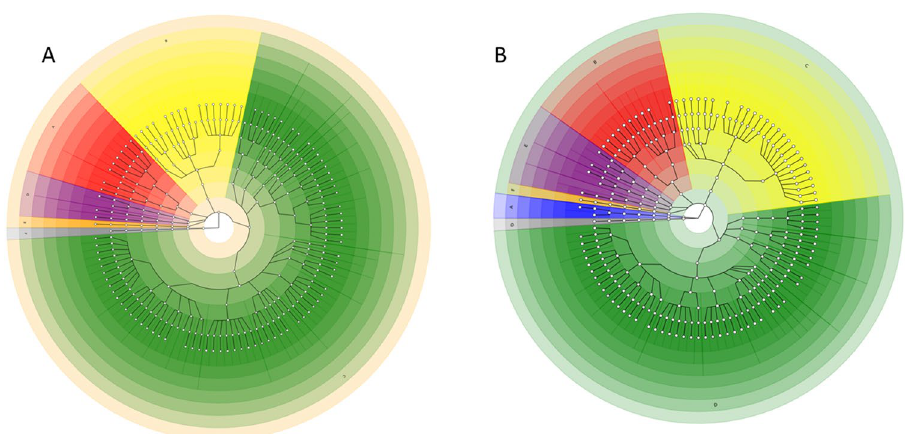
Figure 4. Graphlan generated phylogenetic tree of 16S rRNA based phylogenetic composition of the CF ( A ) and control ( B ) groups. CF legend: A: Actinobacteria (red), B: Bacteroidetes (yellow), C: Firmicutes (green), D: Proteobacteria (purple), E: Verrucomicrobia (orange), F: Viruses (grey). Control legend: A: Archaea (blue), B: Actinobacteria (red), C: Bacteroidetes (yellow), D: Firmicutes (green), E: Proteobacteria (purple), F: Verrucomicrobia (orange), G: Viruses